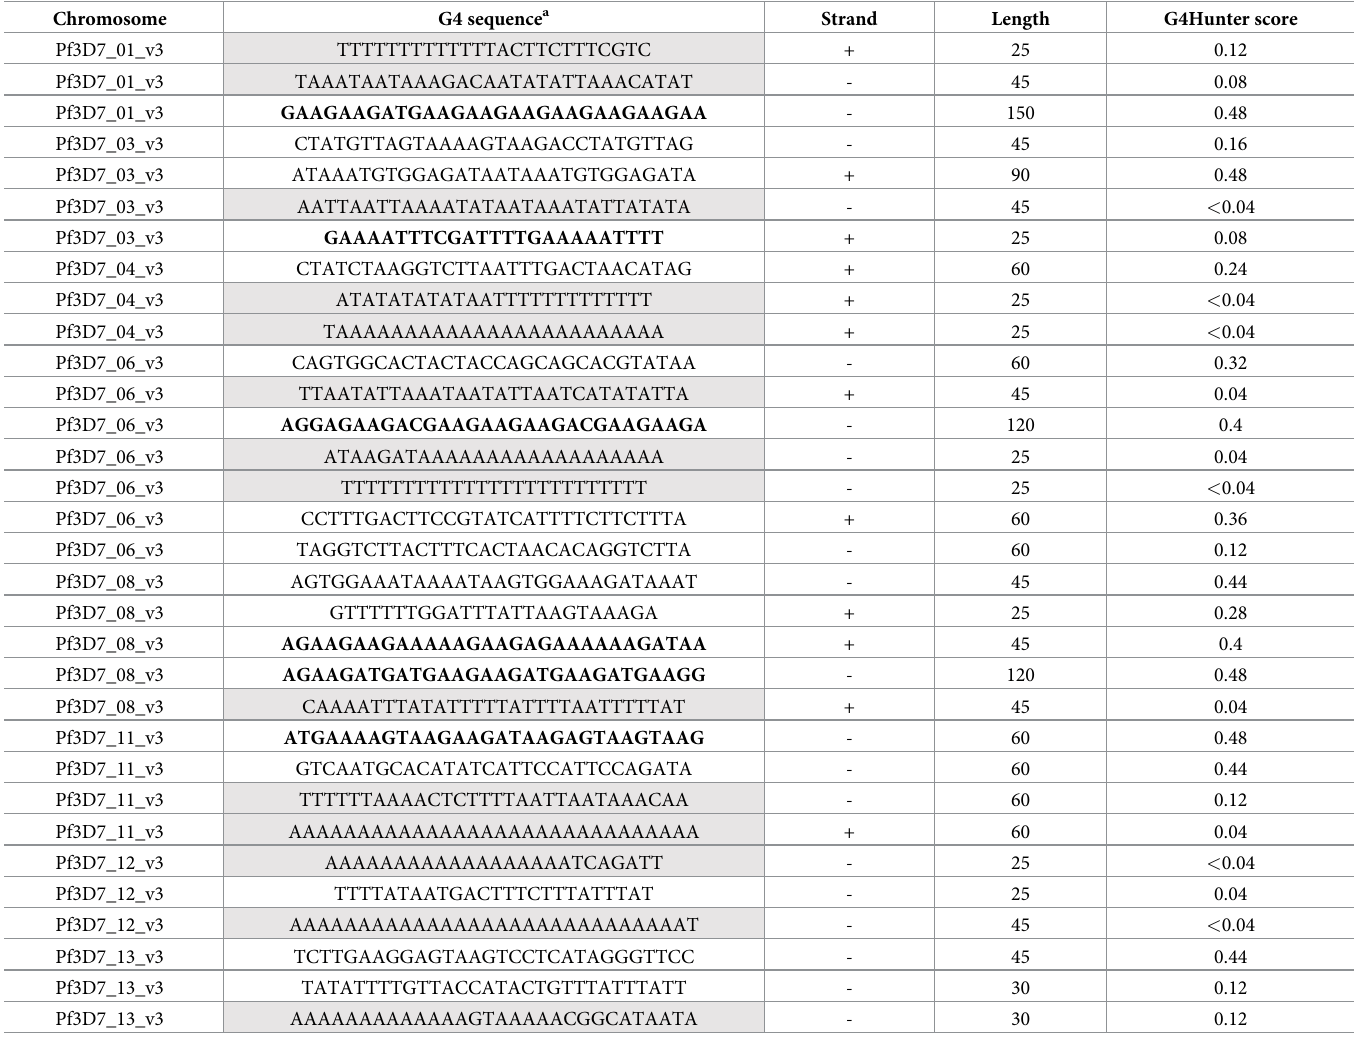
Table 2. Observed G-quadruplexes (OQs) identified by G4-seq [31] that do not overlap with G4H1.2 and that exhibited a G4Hunter score below 0.5. DNA sequences and the score of the “best” G4 identified by G4Hunter in these G4-seq hits are shown. OQs with GA/GAA motifs or with AT repeats are highlighted in bold and in grey,